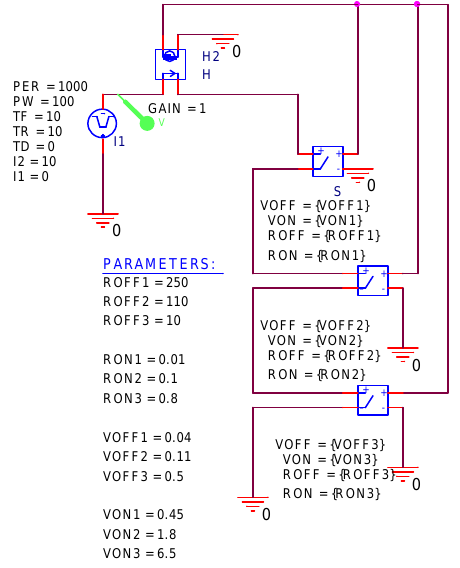
Figure 17: Serial “Switch” model proposal The R(I) curves obtained with a 3 switches configuration is plotted on Fig. 18 for the particular application that we will introduce in next part. Resulting V/I curve is provided on Fig. 19. The accuracy obtained with only 3 switches is already good, but could anyway be improved with additional ones, by making effective each switch on a smaller current band.